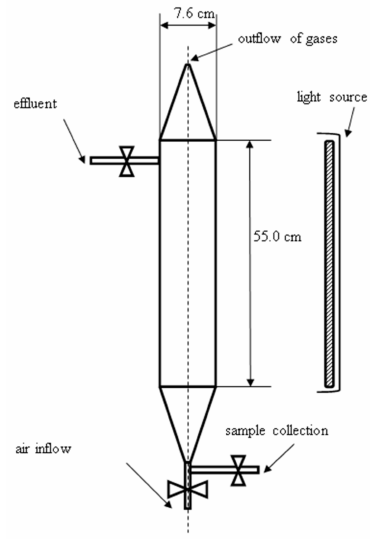
Figure 4. Scheme of the